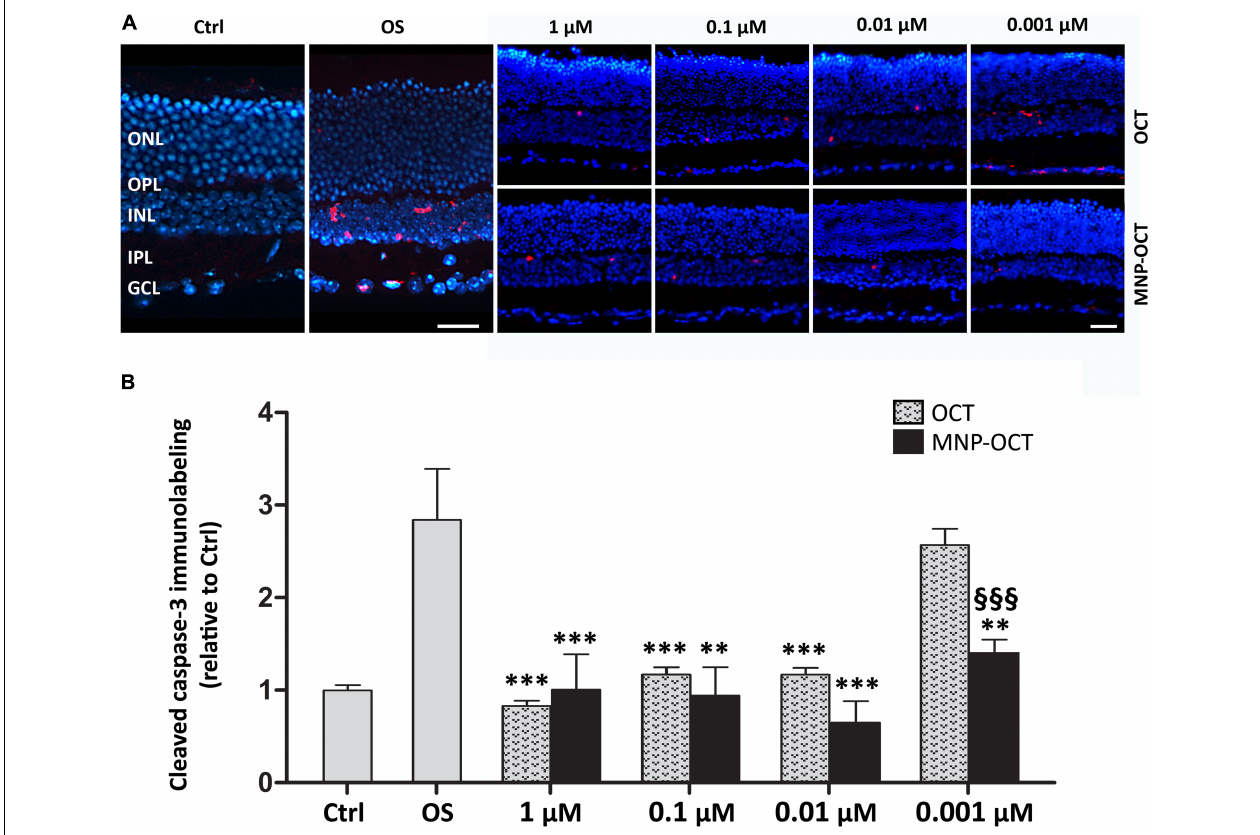
FIGURE 5 | (A) Representative immunofluorescence images of cleaved caspase-3 in sections of retinal explants cultured in control conditions (Ctrl), in OS and following OCT or MNP-OCT treatment, as indicated. Retinal layers are visualized with DAPI counterstaining. Scale bar, 50 µ m. (B) Quantitative analysis of the number of cleaved caspase-3 immunopositive cells per unit length of retinal section. Values are indicated as the mean ± SEM. ∗∗ p < 0.01 and ∗∗∗ p < 0.001 vs. OS; §§§ p < 0.001 vs. OCT; n = 3. Retinal layer abbreviations as in Figure 4